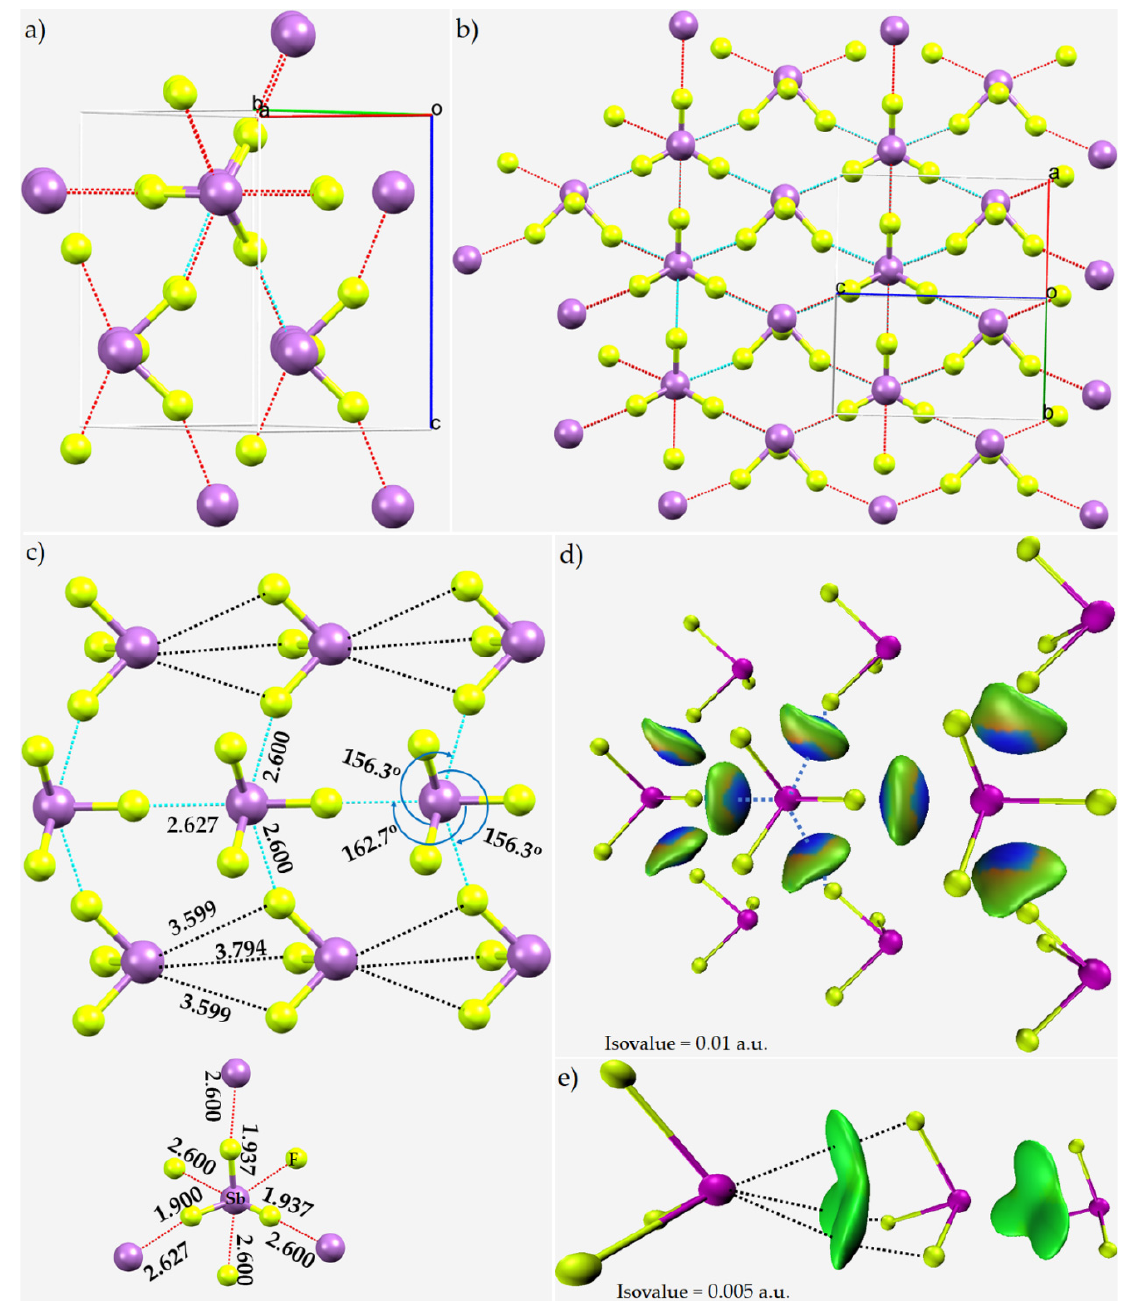
Figure 8. ( a , b ) The unit-cell and 2 × 2 extended crystal structures of SbF 3 (ICSD ref. 16142), respec- tively; the latter shows a pseudo 3D framework of the system. ( c ) Illustration of the local topology bonding between the SbF 3 units in the crystal. ( d , e ) Representation of the IGM- δ g based isosurface topologies between the SbF 3 units in the crystal. Selected bond lengths and bond angles are in Å and degrees, respectively. Blue and green isosurfaces in ( d , e ) represent strong and weak interactions between F and Sb in the crystal, and were calculated at different isovalues. Intermolecular interactions between molecular entities are represented by dotted